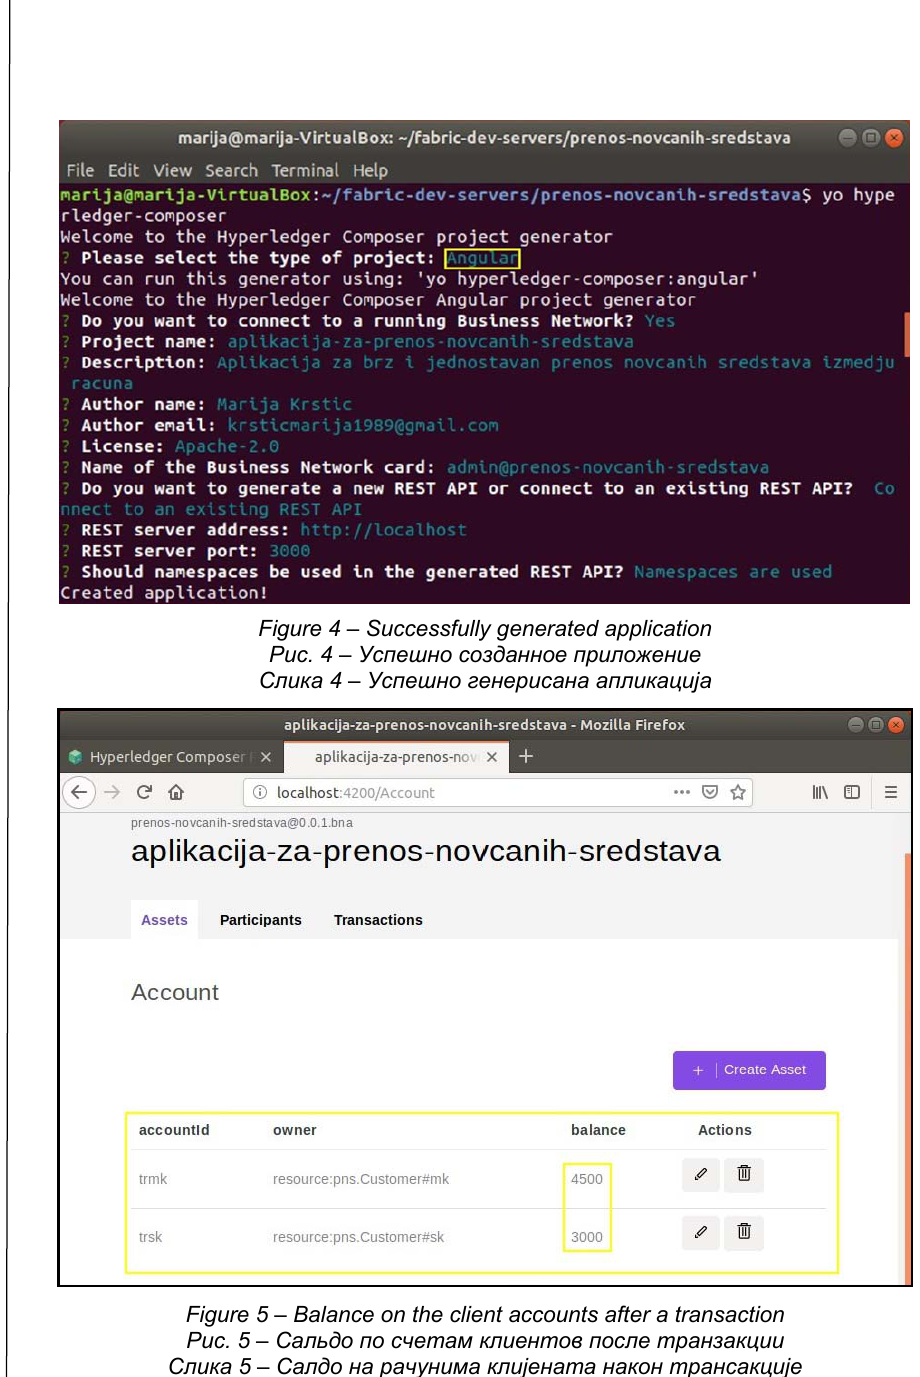
Figure 5 – Balance on the client accounts after a transaction Рис . 5 – Сальдо по счетам клиентов после транзакции Слика 5 – Салдо на рачунима клијената након